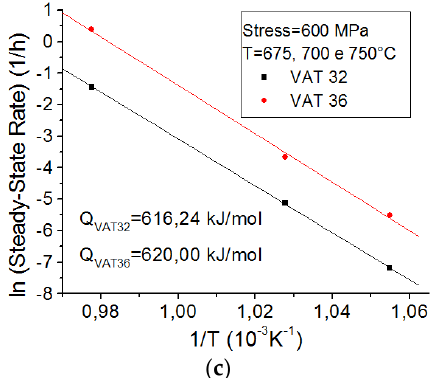
Figure 12. Steady-state creep rate dependence with the temperature for the alloys VAT 32 and VAT 36 at: ( a ) 500 MPa. ( b ) 550 MPa and ( c ) 600 MPa. At 675 °C a stress exponent of 14.80 was obtained for the VAT 32 and 13.72 for the VAT 36. At 700 °C, n values reached 14.18 for the VAT 32 and 13.10 for the VAT 36. At 750 °C the stress exponents